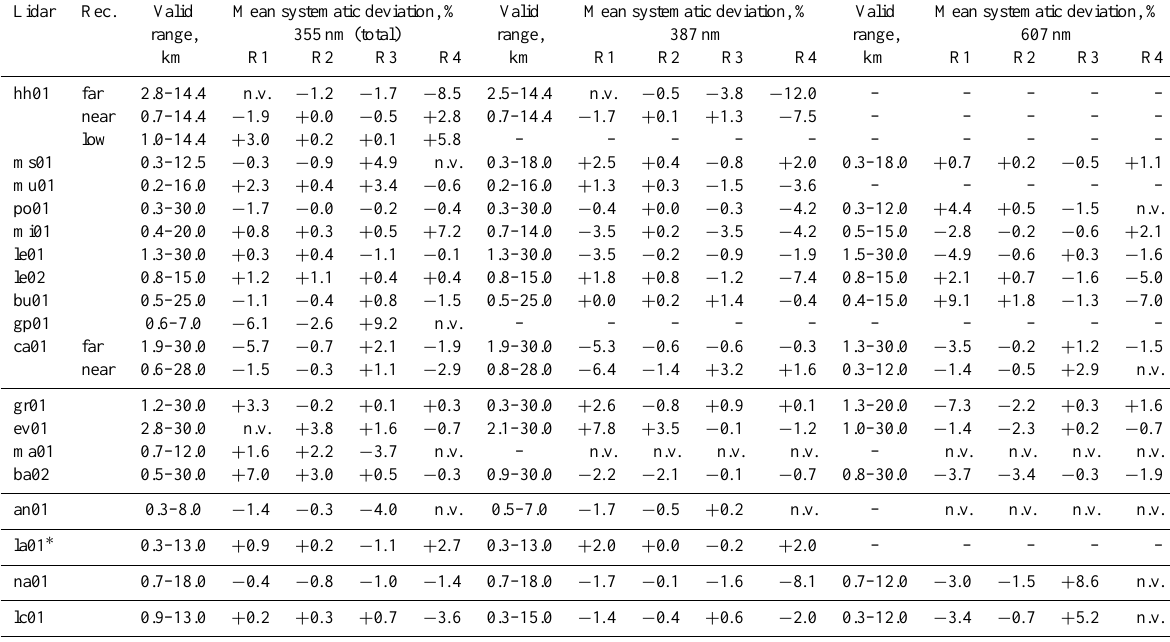
Table 3. Valid range and mean systematic deviation of signals at 355, 387, and 607nm in four height ranges: R1 (lowest valid range–2.5km), R2 (2.5–6km), R3 (6–12km), and R4 (12km–highest valid range). n.v. denotes not valid. Rec. denotes receiver range. Lidar